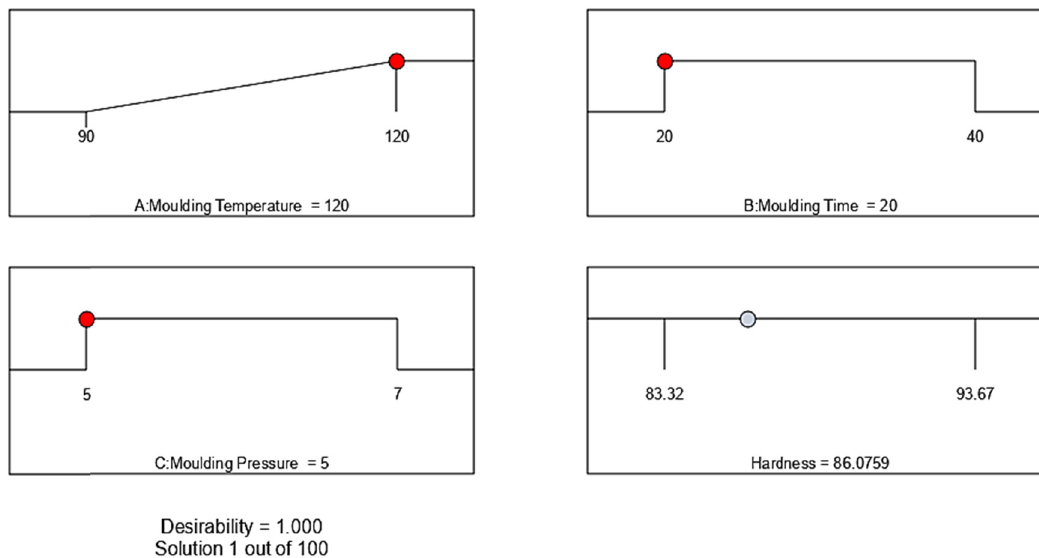
Figure 23: Ramp function graph for hardness.